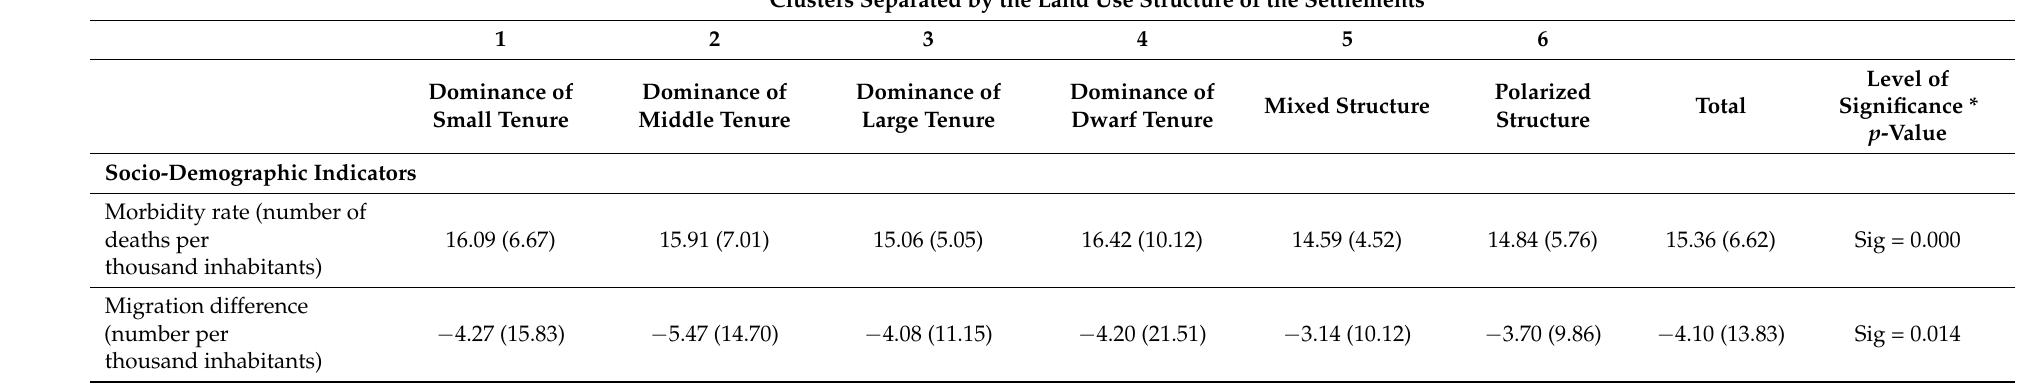
Table A2. Deviation of the six settlement clusters according to socio-demographic and social indicators, average values (corresponding standard deviations in